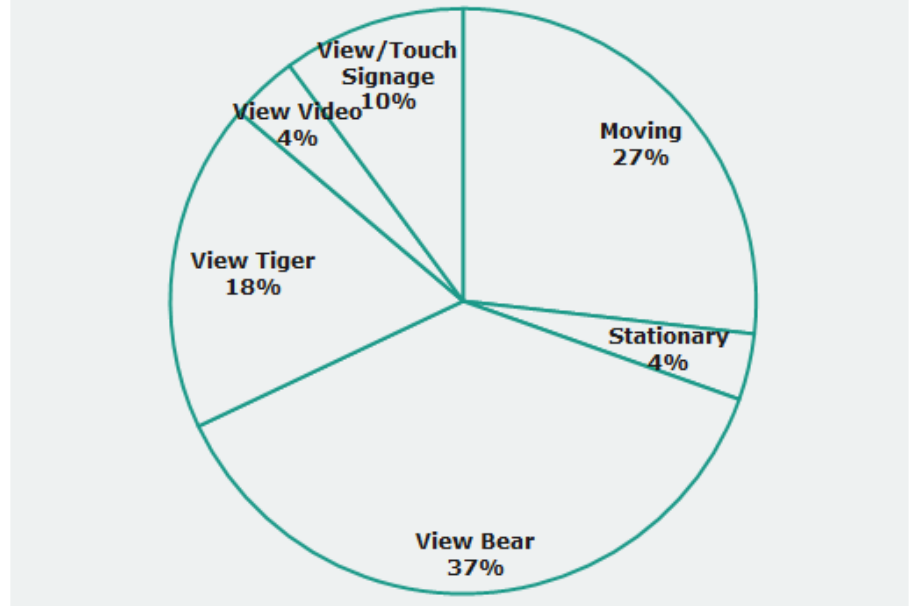
Chart Illustrating Visitor Time Spent Engaging in Various Behaviors at the Sun Bear/Tiger Terrace